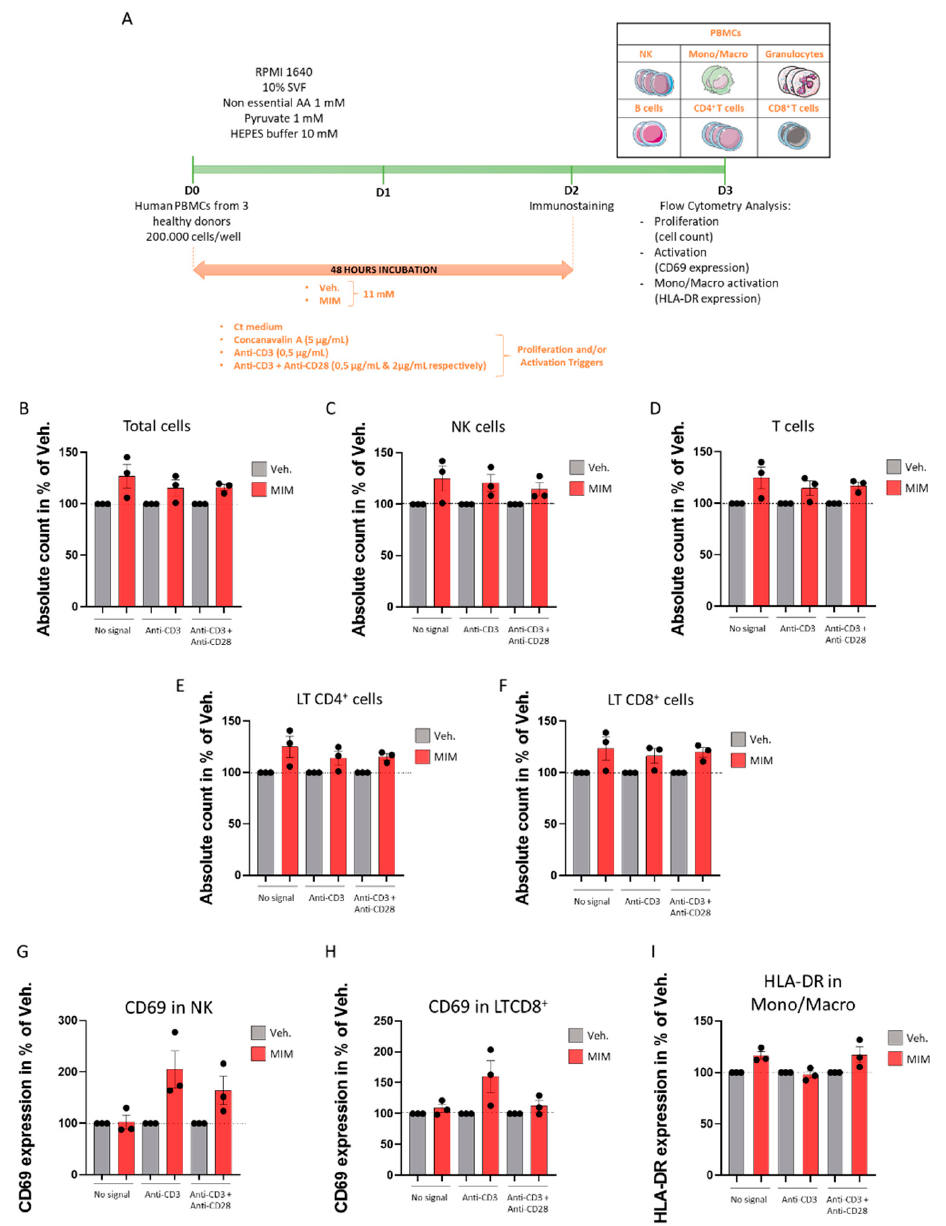
Figure 4. MIM increases the proliferation and the activation of PBMCs in vitro. ( A ) Representative scheme of the experimental protocol. Human PBMCs from three healthy donors were cultivated for 48 h in (i) classical culture condition (Ct medium, referred to as “no signal”), (ii) classical culture